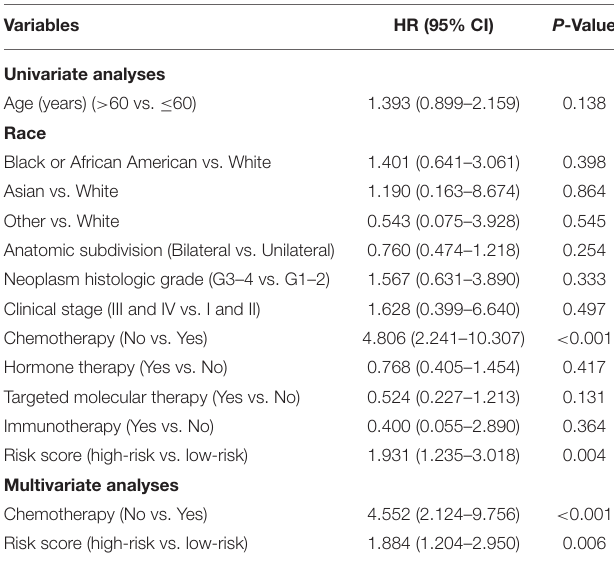
TABLE 4 | Univariate and multivariate analyses of risk factors and OS in the validation cohort.